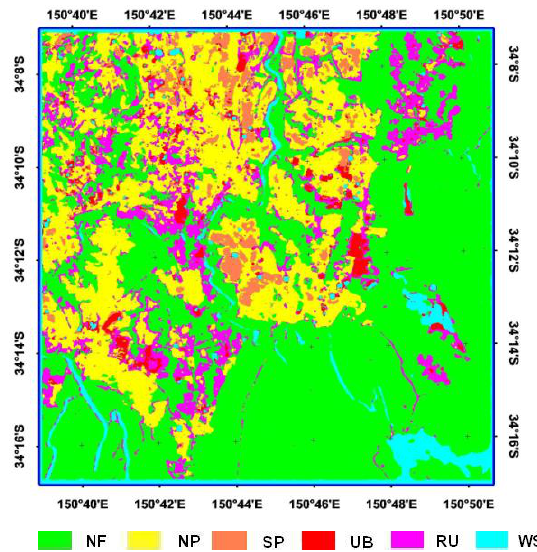
Figure 4. Results of classification using FS-GA with SVM classifier.